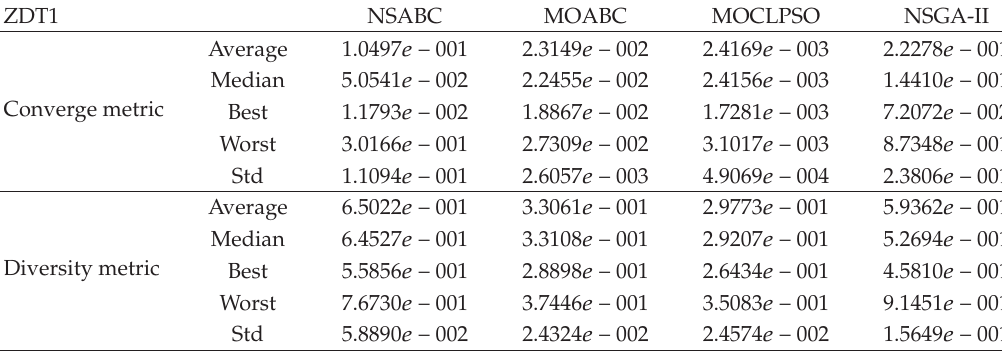
Table 5: Comparison of performance on ZDT1 after 10000